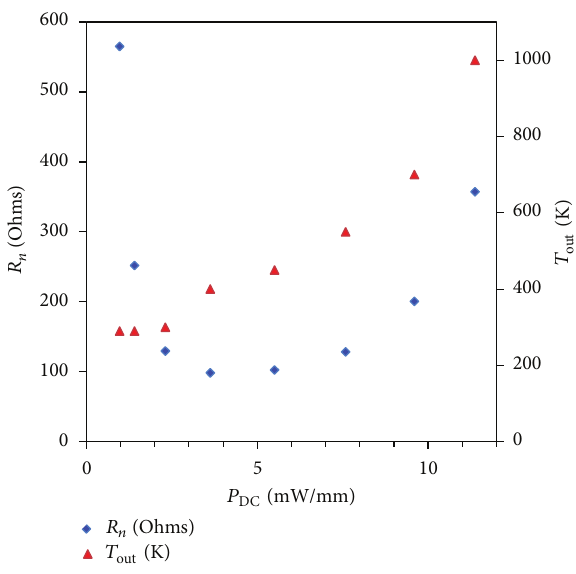
Figure 9: Minimum noise figure NF min and associated gain 𝐺 a function of power consumption at 12GHz for 𝑉 𝑑𝑠 = 80 mV.